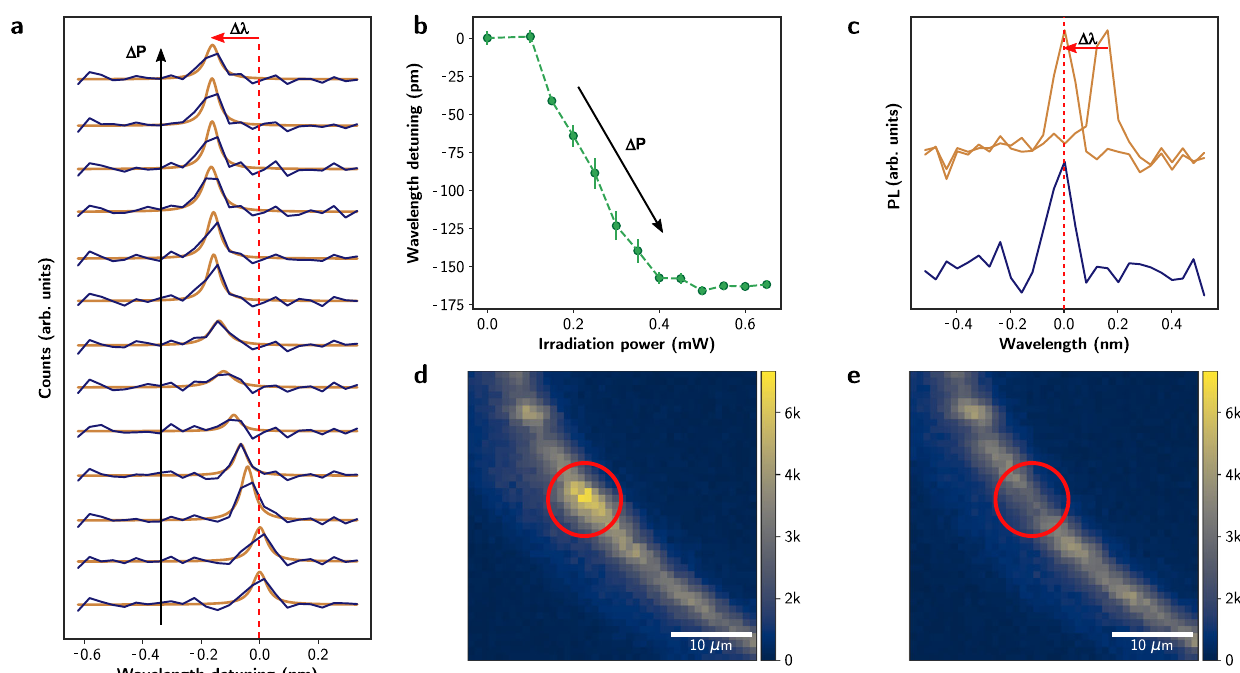
Fig. 4 | Non-volatile trimming of color centers using light. a Example of non- volatilespectral shifting of the ZPL of arti fi cialatoms causedbyoptical irradiation, with the data represented in blue and the Lorentzian fi t in orange. b Fitted ZPL central wavelength under increasing optical irradiation power. Error bars denote